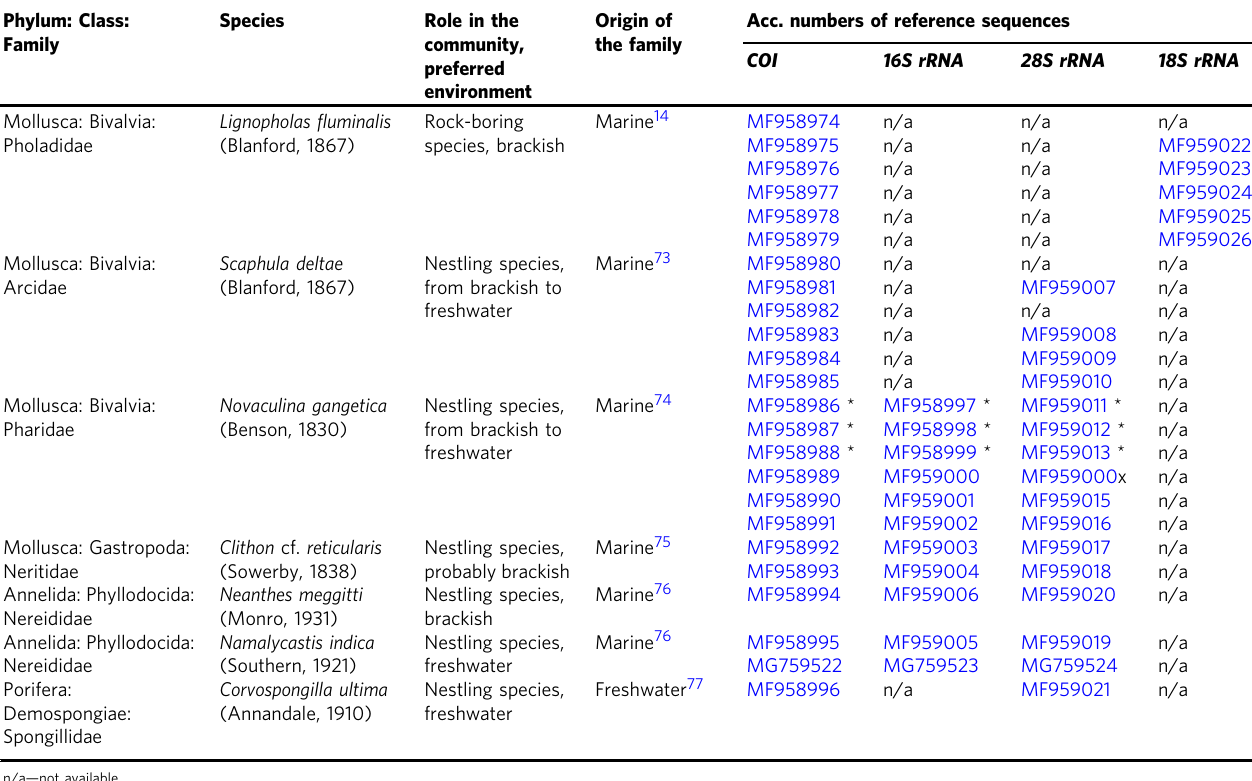
Table 1 Taxonomy, ecology, and reference sequences of freshwater rock-borer community ’ s members from Kaladan River, western Myanmar Phylum: Class: